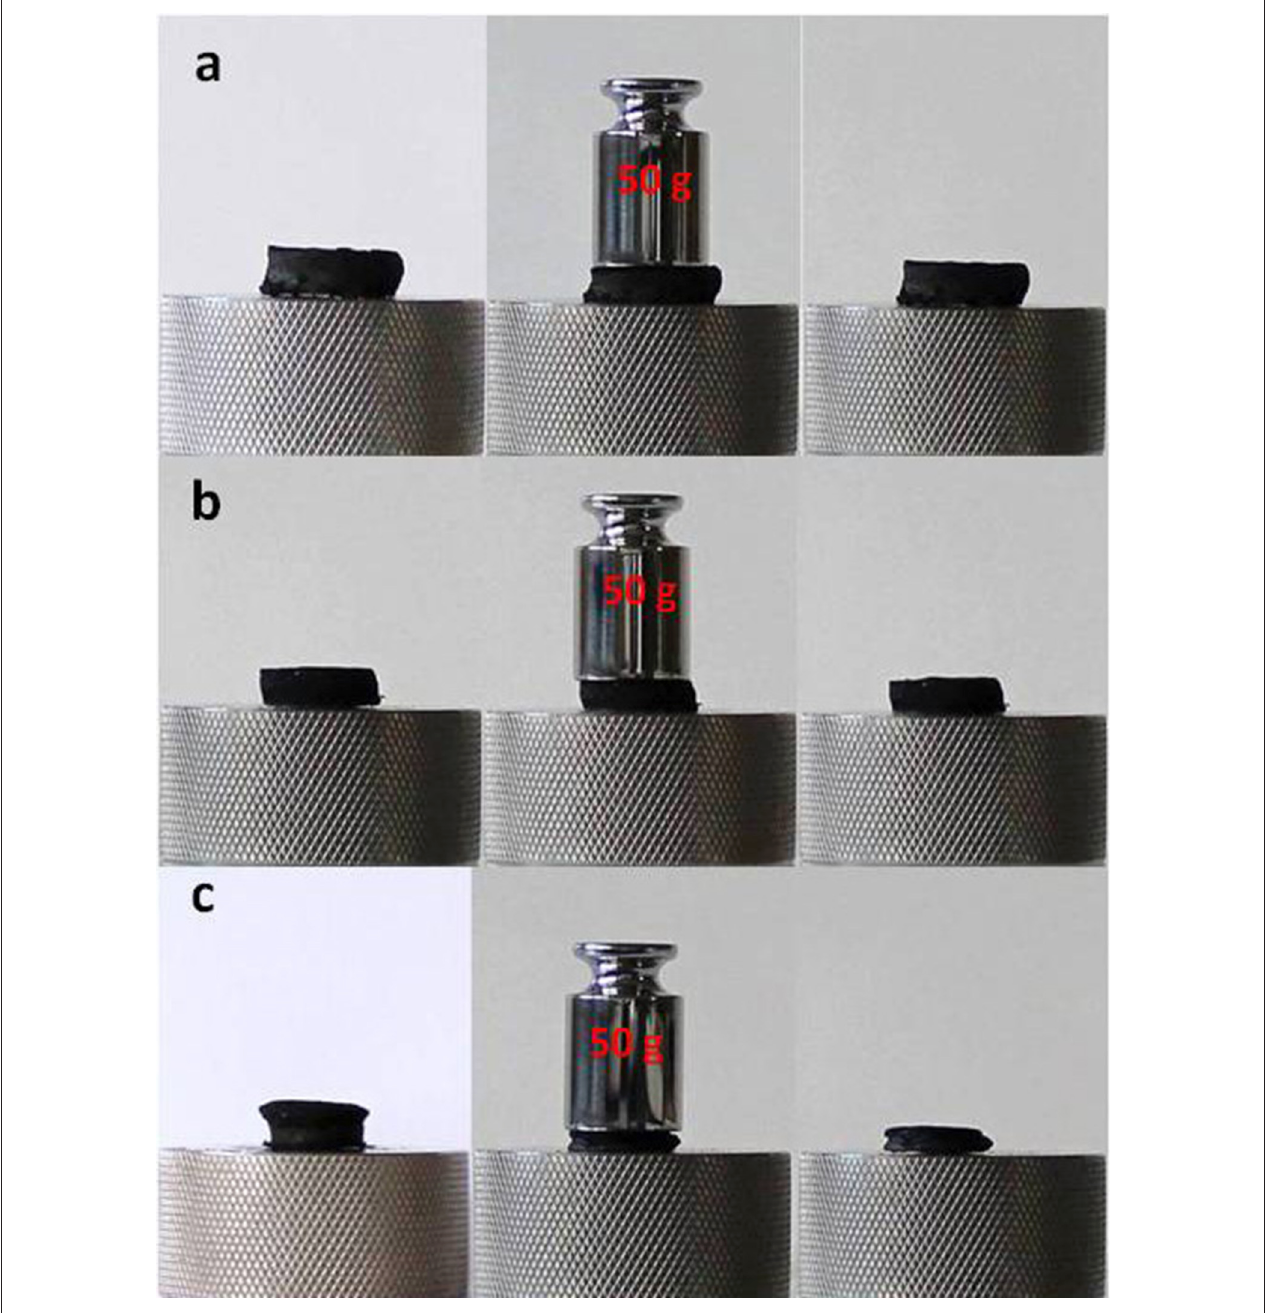
FIGURE 11 | The compression of (a) rGO OPD (b) rGO HDA (c) rGO TETA aerogel cylinders after the placement of a 50g standard precision